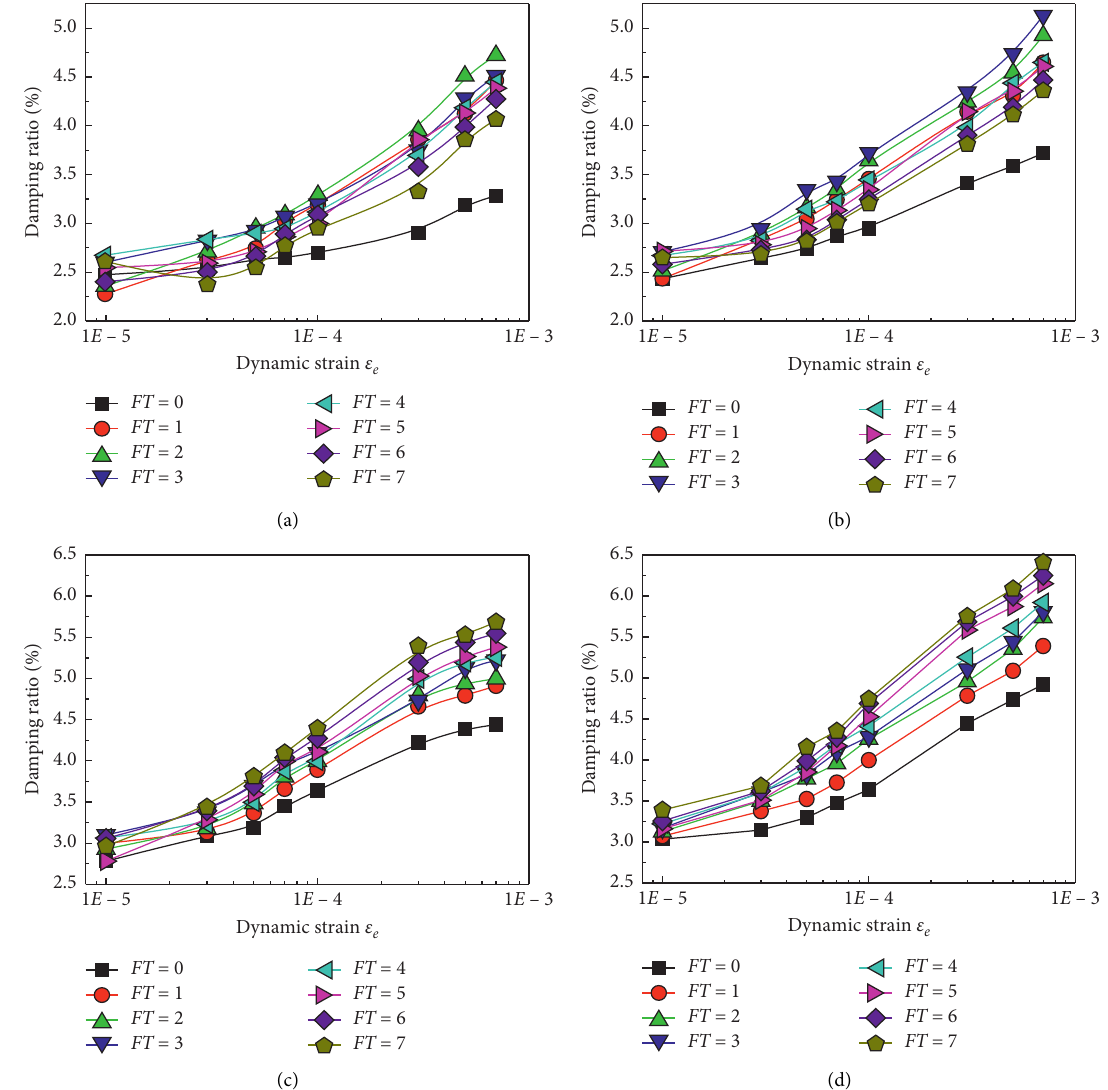
Figure 9: The relationship between damping ratio and dynamic strain of the unreinforced and reinforced expansive soil samples under these two stress states after different freeze-thaw cycles. (a) σ 3 � 50kPa, unreinforced sample. (b) σ 3 � 50 kPa, reinforced sample. (c) σ 3 � 10kPa, unreinforced sample. (d) σ 3 � 10kPa, reinforced